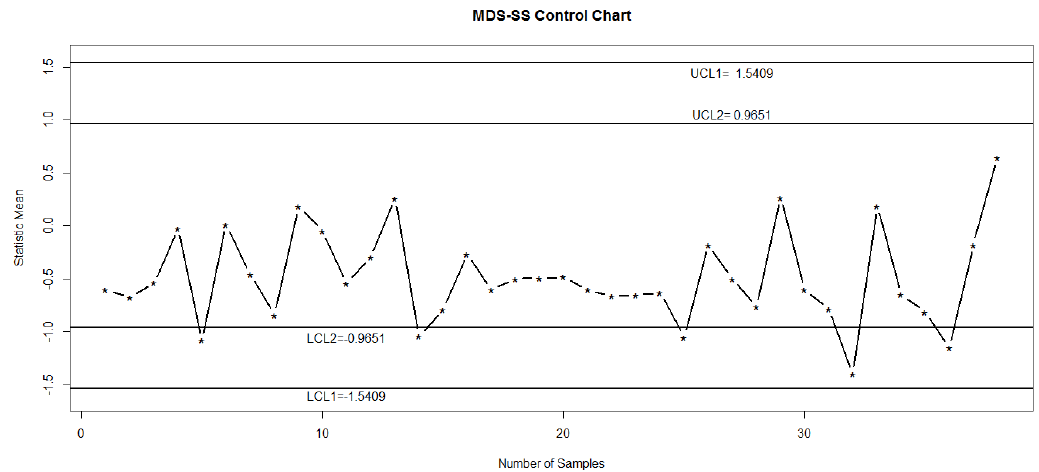
Figure 5. Control chart using MDS sampling for simulation data: ARL 0 = 370 for i = 2 and ρ = 0.6 with n = 30.